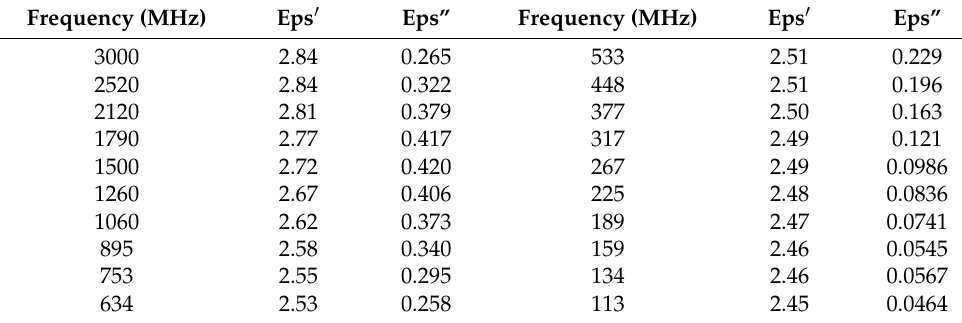
Table 2. LDPE dispersion model data list